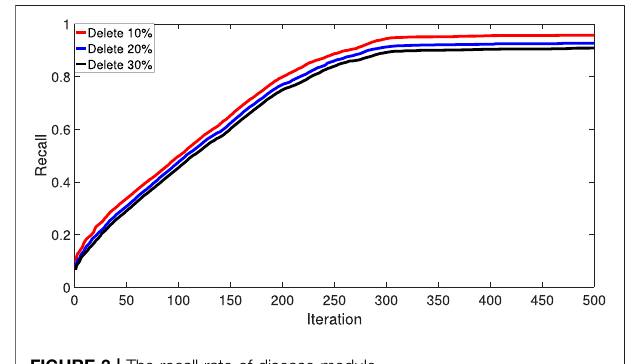
FIGURE 3 | The recall rate of disease